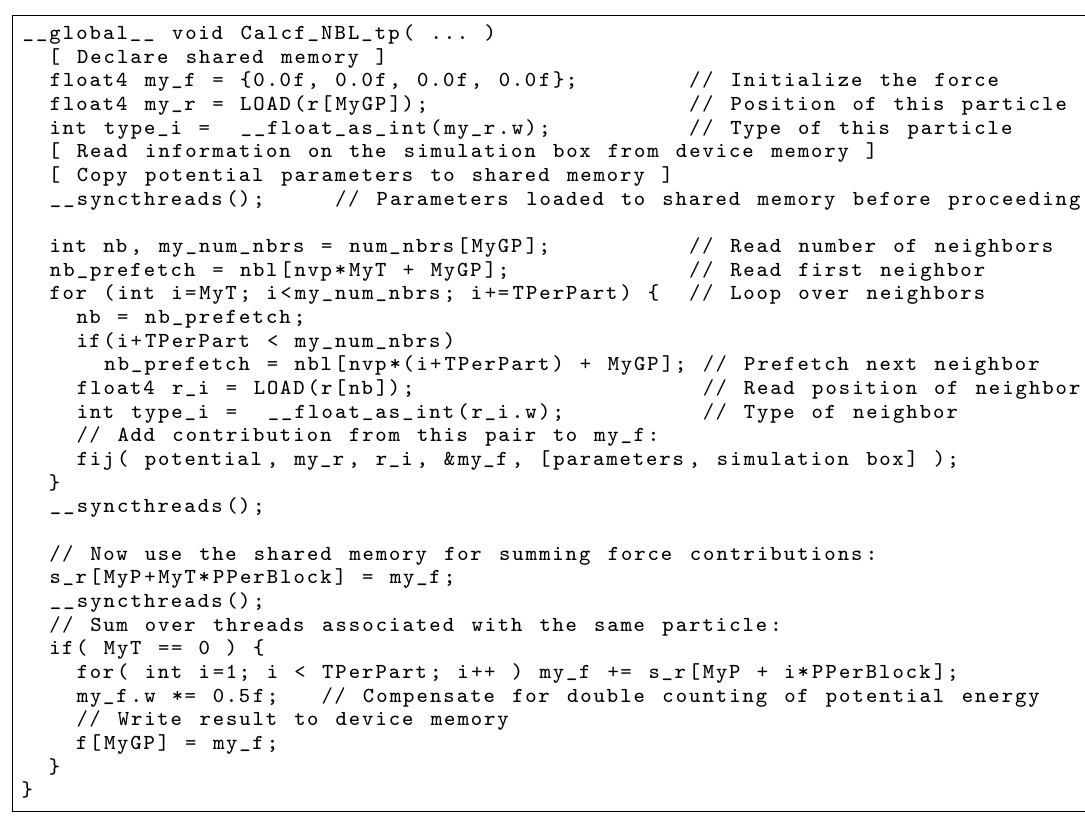
Figure 3: Kernel calculating forces on particles given the neighbor-list ( nbl ) shown in the simplest version where only the force and potential energy of each particle are computed. For − 1) computes part of the total force, which a given particle each of t threads ( MyT = 0,1,..., t p p is summed up at the end. The function fij (not shown) adds an individual pair contribution to the current thread’s force ( my_f ). Note the use of __syncthreads to synchronize threads within a thread-block. This is to ensure that all data are available in shared memory before any thread reads from it (first and third occurrences) or that all threads are done with the data in shared memory before it is used for other data (second occurrence). LOAD() is a macro that reads from device memory via the read-only data-cache using __ldg() on cards where this is